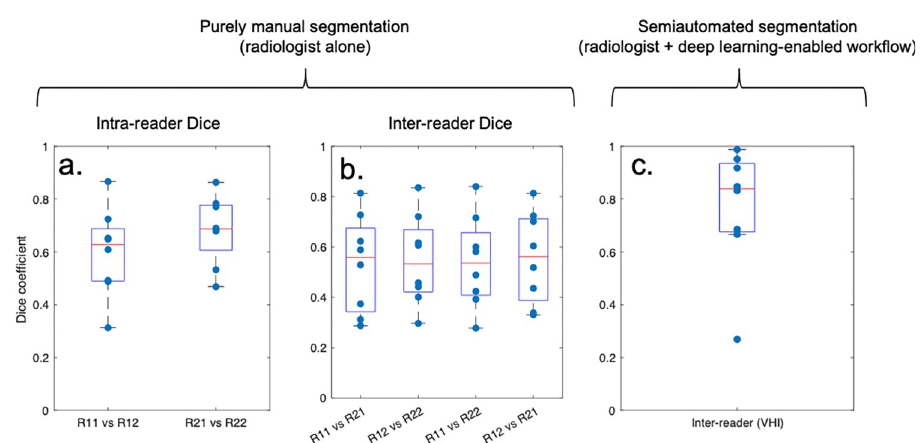
Fig 4. Improvement in Dice scores for human-machine workflow compared to purely manual segmentation. Dice scores are shown for individual patients for trials of segmentation of inflammation (volume comparison): (a) and (b) show results for purely manual segmentation and (c) shows results for corrected automatic (i.e. semiautomated) segmentations. (a) shows within-reader results, (b) shows between- reader results and (c) shows between-reader results. R stands for reader with the first subscript corresponding to the reader and the second to the segmentation ij trial. The figures show boxplots with individual datapoints superimposed; the red line represents the median dice.